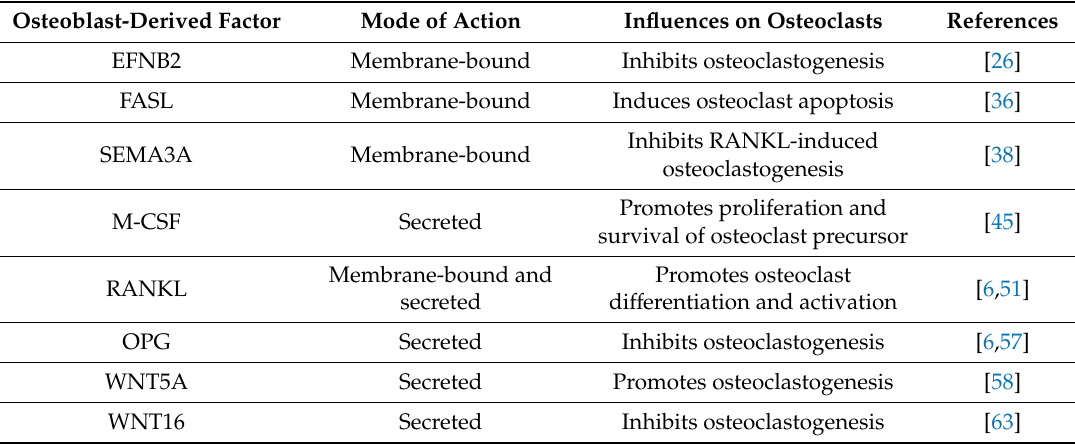
Table 1. Summary of the e ff ect of osteoblast-derived factors on osteoclast behavior. Osteoblast-Derived